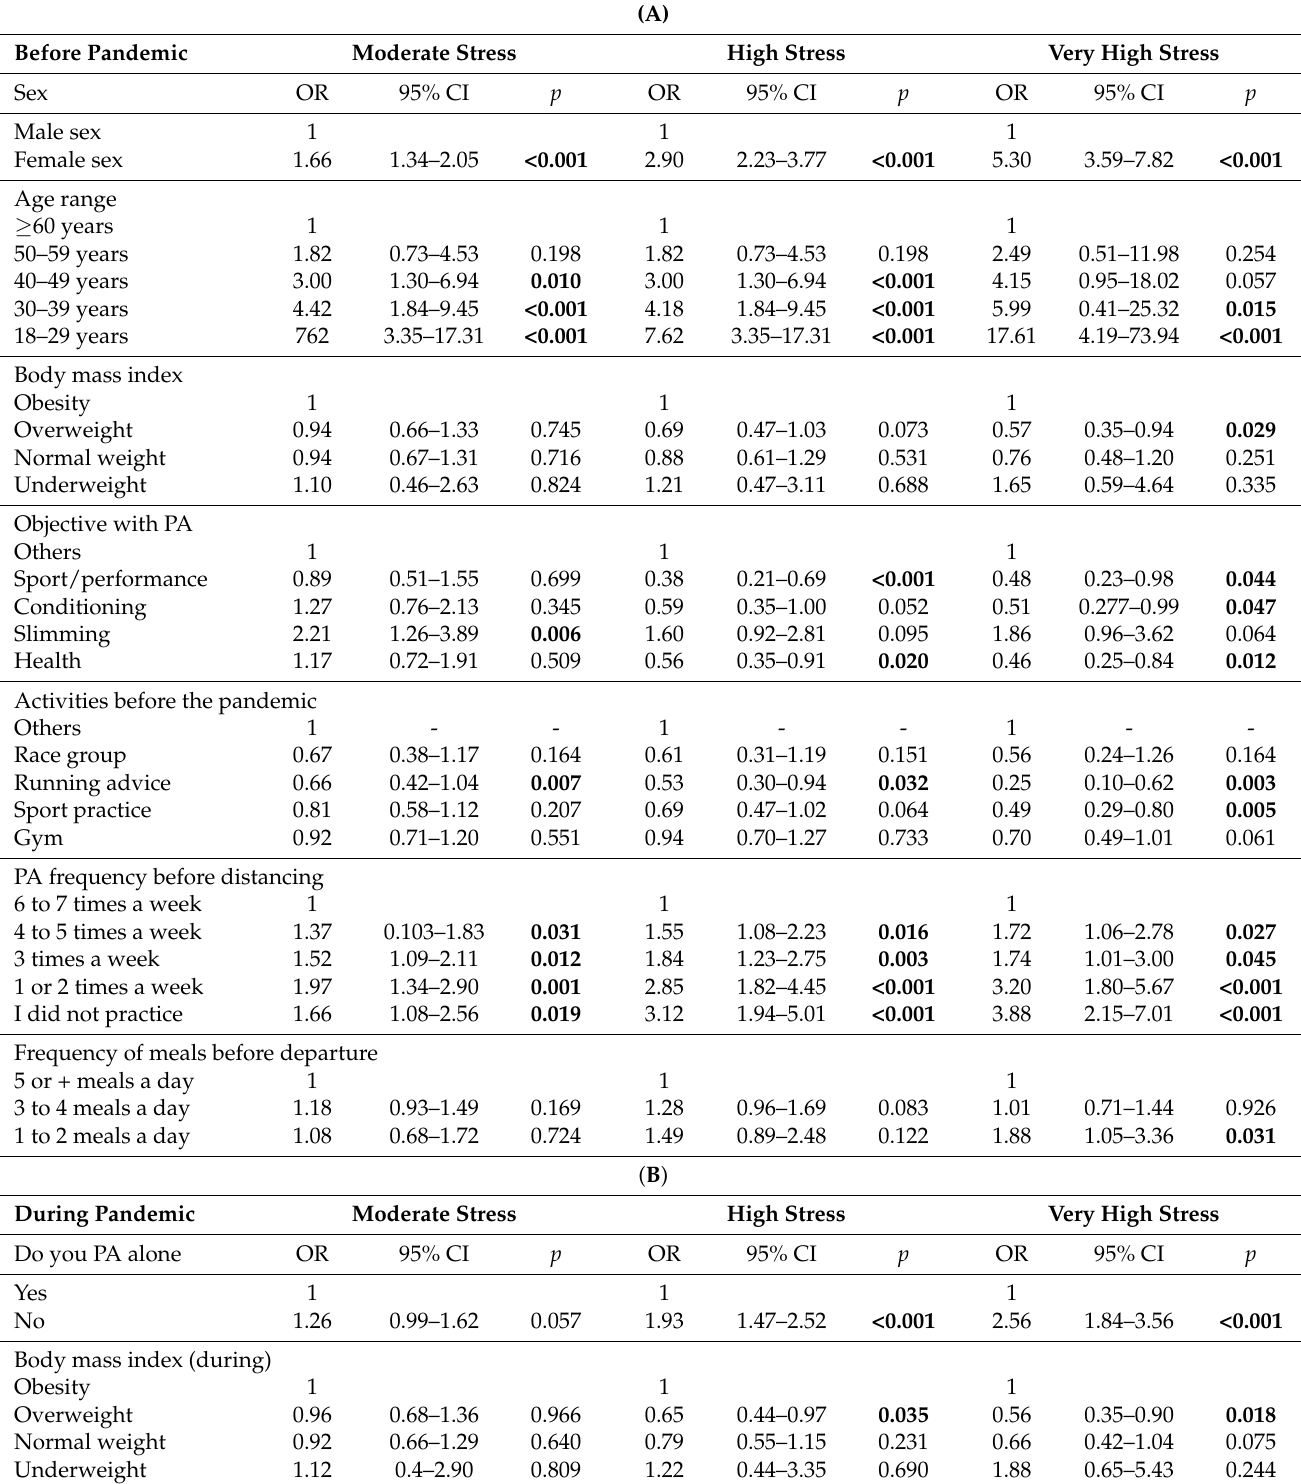
Table 2. ( A ) Association of the variables included in the study according to psychological distress (anxiety and depression), related to the conditions before social distancing (N = 2000). ( B ) Association of the variables included in the study according to psychological distress (anxiety and depression) related to the conditions during social distancing (N =